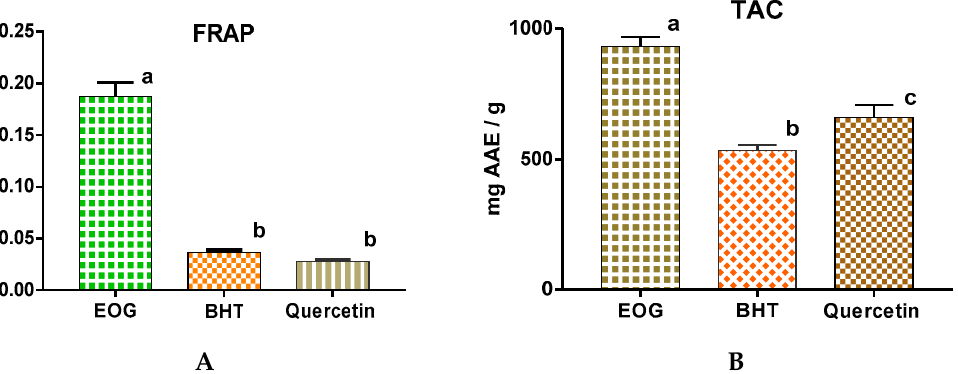
Figure 4. Antioxidant activities of EOs of J. thurifera by the FRAP method ( A ) and antioxidant capacity of EOs of J. thurifera ( B ). Bars with the same letters do not differ significantly (p < 0.05).